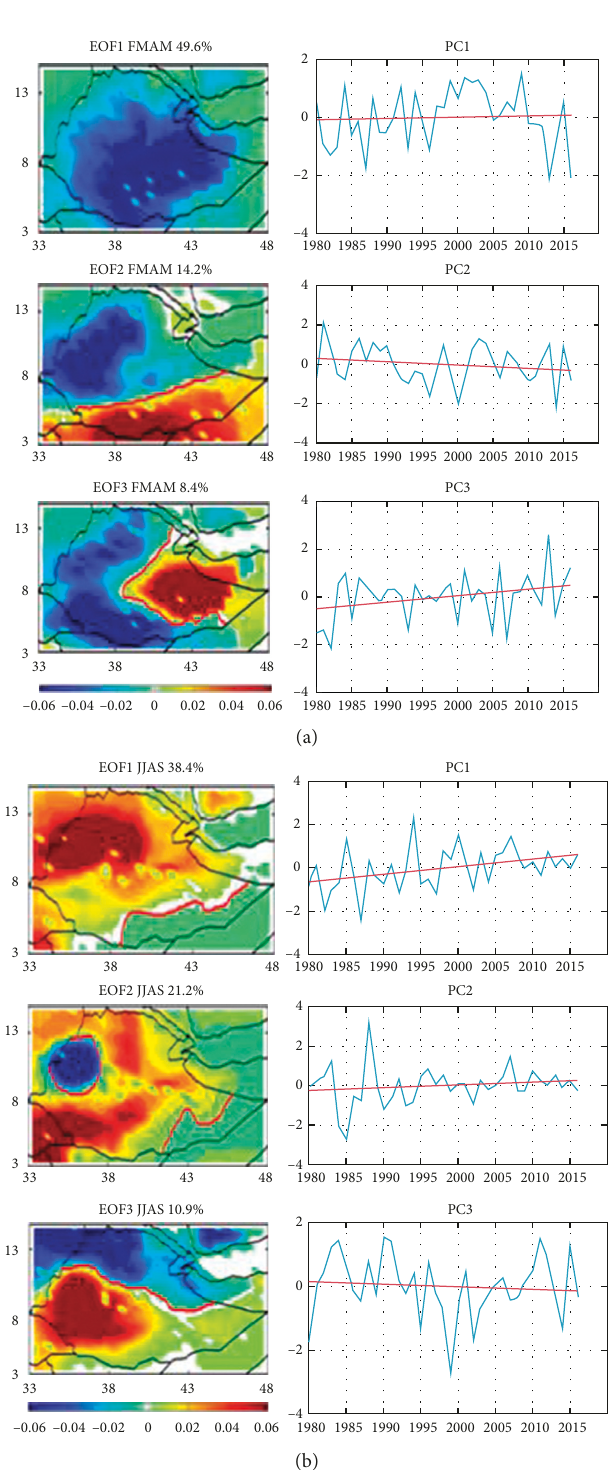
Figure 4: Three leading modes of EOF and principal component analysis (PCA) of FMAM (a) and JJAS (b) seasonal